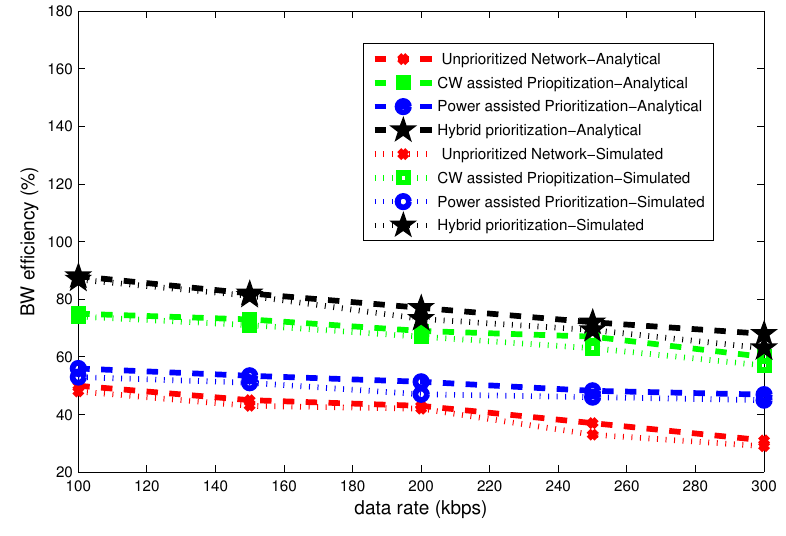
Figure 16. Effect of data rate on bandwidth